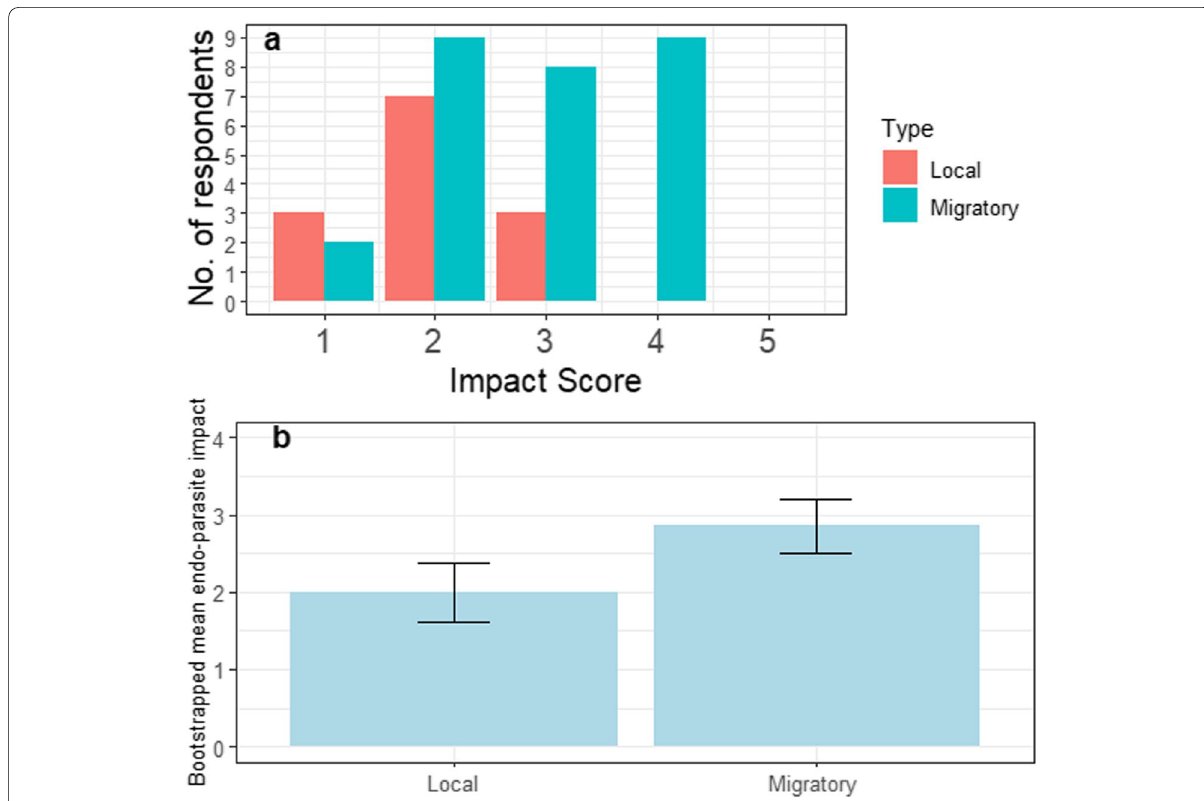
Fig. 5 Panel graph displaying a impact scores of endo‑parasites on livestock health and b bootstrapped mean and 95% CI endo‑parasite impact scores for outlying and village‑based livestock. 5, animal dies; 4, alive but useless (in terms of owner‑defined measures of productivity); 3, severely impacted; 2, impacted but not so severely; 1, little impact; 0, barely